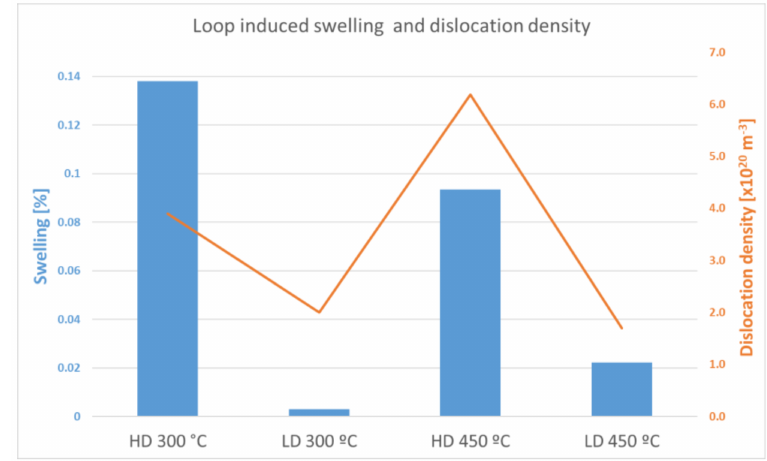
Figure 24. Dislocation-induced swelling and density.